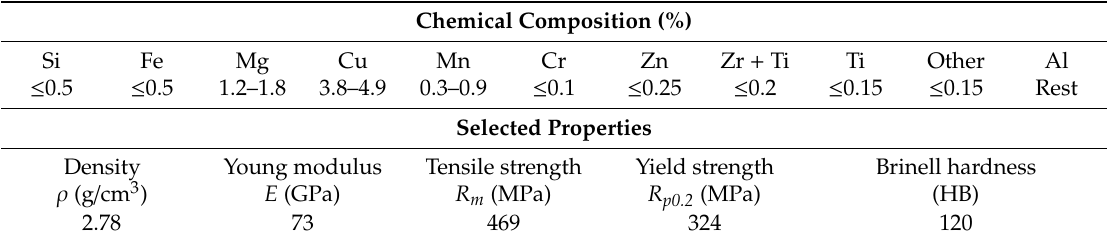
Table 2. The chemical composition and selected properties of the EN AW-2024 T351 alloy [26,27].